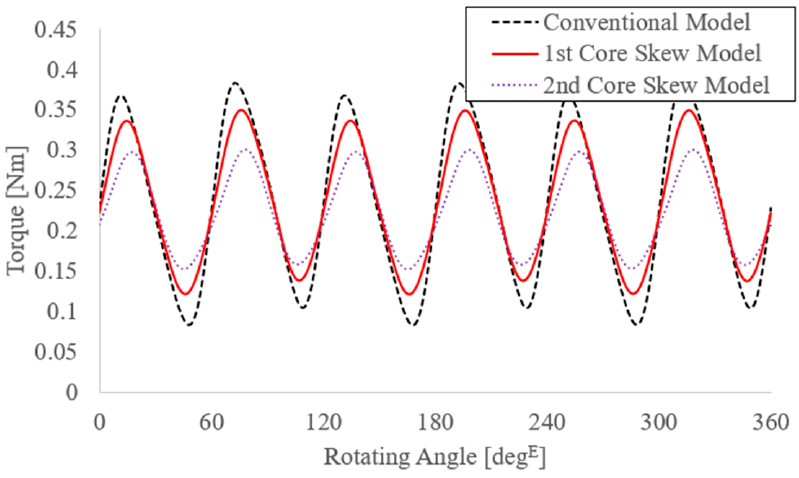
Figure 12. 15,660 rpm torque waveform comparison.